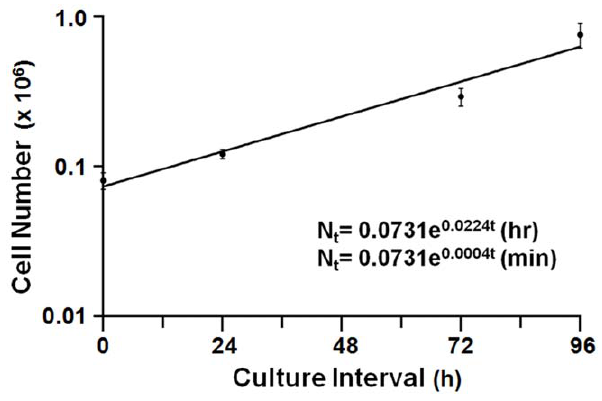
Figure 4. HeLa cell expansion under transcriptional chase conditions. Data from dox-supplementation experiments in Fig. 2 (1 m g/mL) was regressed to an exponential function, and expansion factors defined [j=0.0224 (h) or 0.0004 (min)].